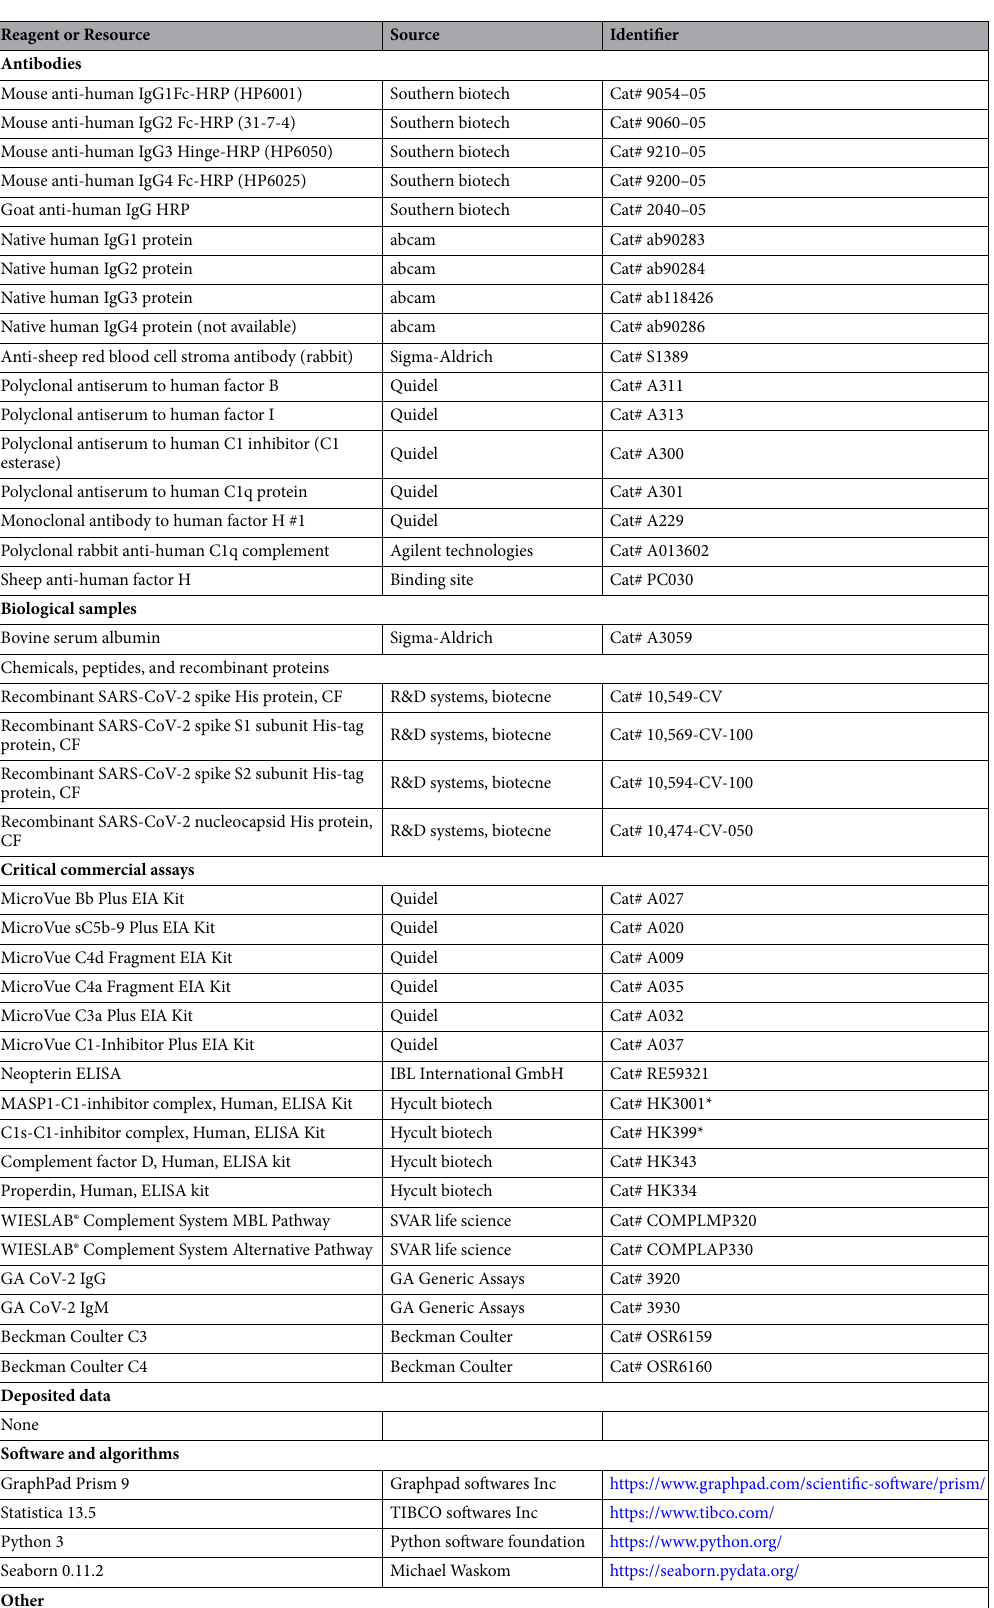
Table 2. Key resources. *not yet available